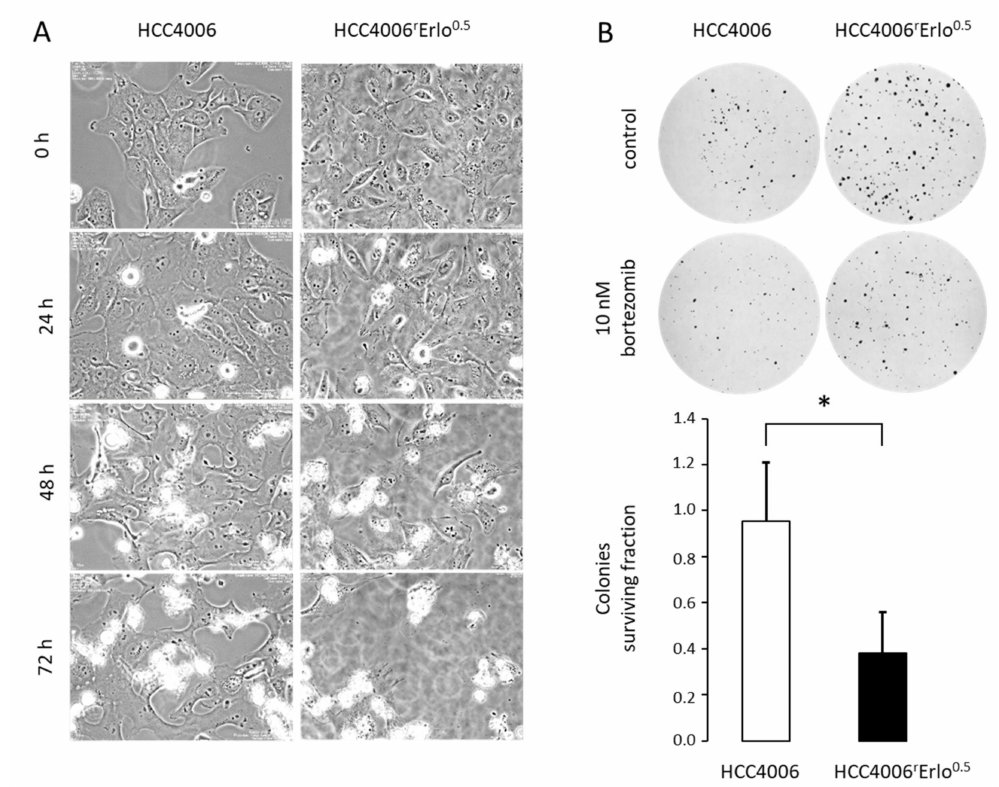
Figure 5. HCC4006 r Erlo 0.5 cells are more sensitive to bortezomib compared to their native HCC4006 cells. ( A ) HCC4006 and HCC4006 r Erlo 0.5 cells were cultivated in a time-lapse microscope (Biostation II, Nikon Instruments, Düsseldorf, Germany) at 37 ◦ C and 5% CO 2 atmosphere in the presence of 10 nM bortezomib. Representative images were taken at the indicated time points. ( B ) Cells were plated in 150 mm cell culture dishes, and colonies were allowed to grow for 14 days. After staining with crystal violet, colonies consisting of >50 cells were counted manually. The colonies surviving fraction was calculated as described in the methods section. Values represent mean ± SD, n = 3, * p <